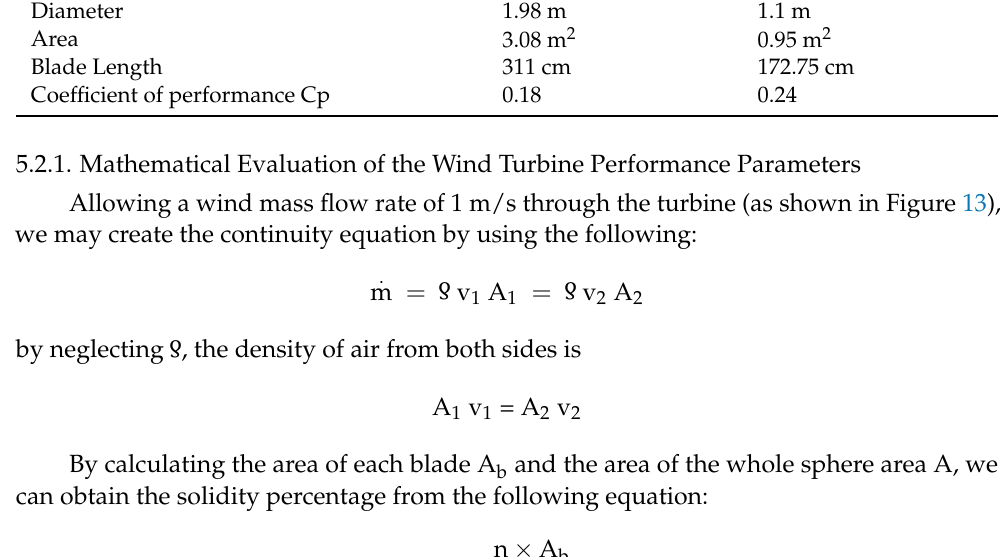
Figure 13. Velocity distribution around the energy ball. Three-dimensional simulations using computational fluid dynamics (CFD) ANSYS FLUENT are shown in Figures 14 and 15, from which the mathematical approach, ex- plained above, is illustrated. The velocity contours demonstrate the creation of low-velocity zones behind the turbine’s nose and high-velocity regions, particularly be- hind the blades. With an increase in tip speed ratio, the low-velocity area expands, and the increased-velocity area concentrates behind the turbine blades at high tip speed rati- A 2 Smaller area Higher wind speed A 1 Bigger area Lower wind speed ms -1